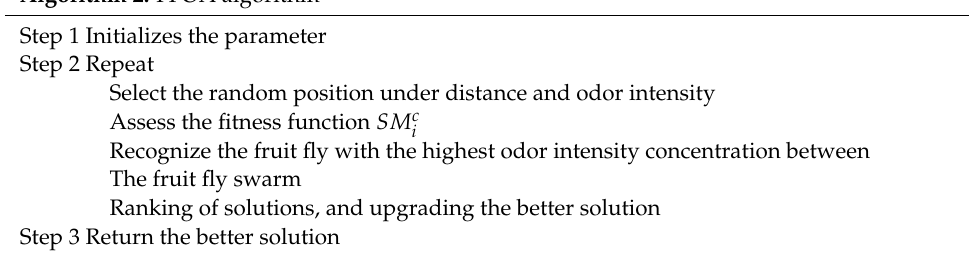
Algorithm 2. FFOA